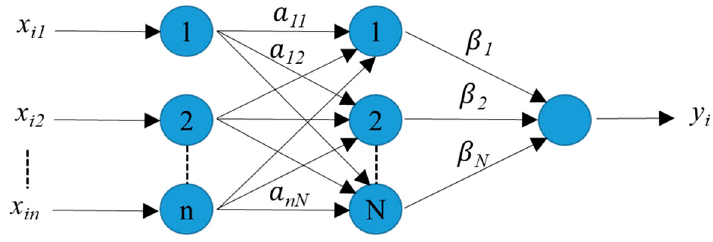
Figure 2. Scheme of the extreme learning machine (ELM) model.